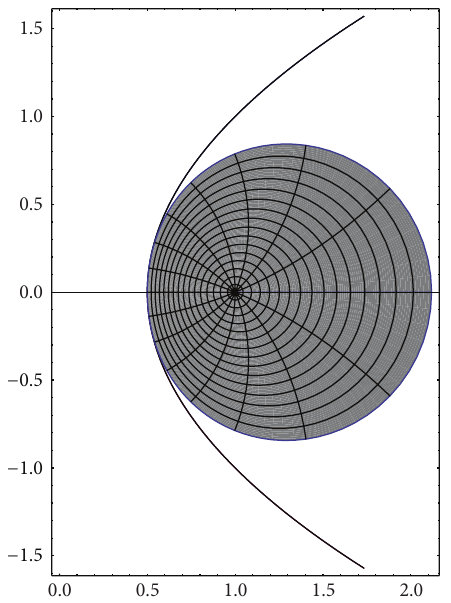
Figure 6: Image of |𝑧| ≤ 0.23605 touches |𝑤 − 1| = Re 𝑤